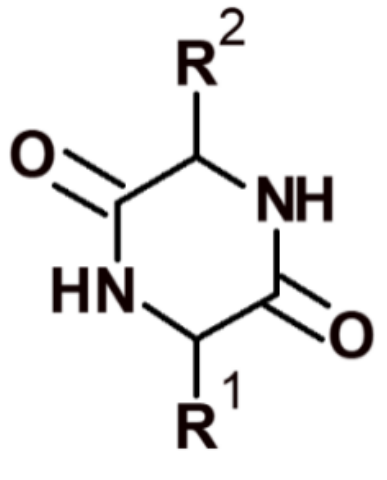
Figure 2. Analog of somatostatin with D -amino acids.